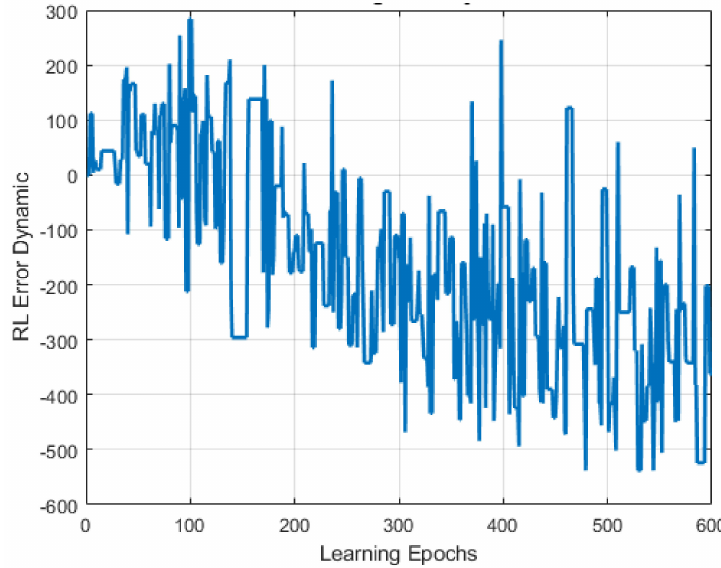
Figure 9. The reward dynamic—during the learning phase—of the defined RL motor map system to correct the trend prediction made by previous deep learning